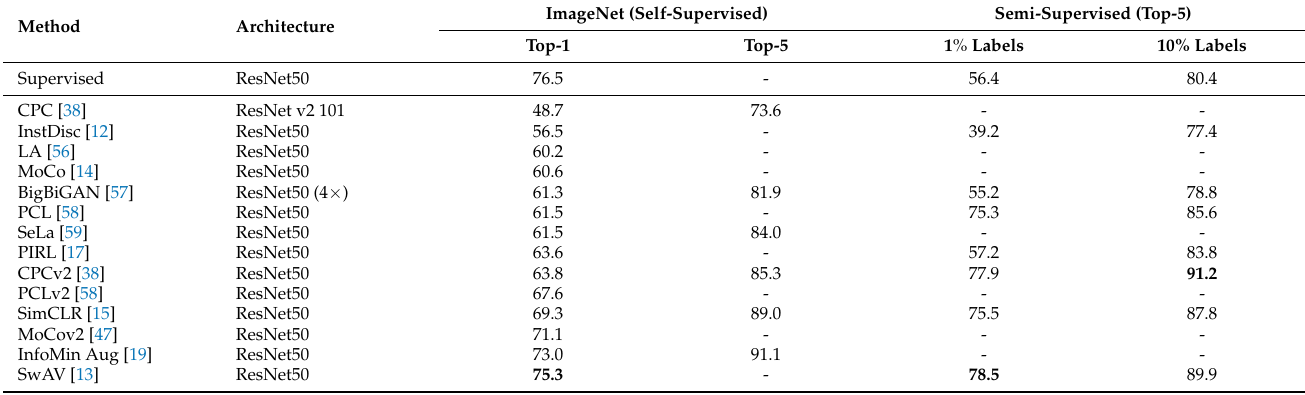
Table 1. Performance on ImageNet Dataset: Top-1 and Top-5 accuracies of different contrastive learning methods on ImageNet using self-supervised approach where models are used as frozen encoders for a linear classifier. The second half of the table (rightmost two columns) shows the performance (top-5 accuracy) of these methods after fine-tuning on 1% and 10% of labels from